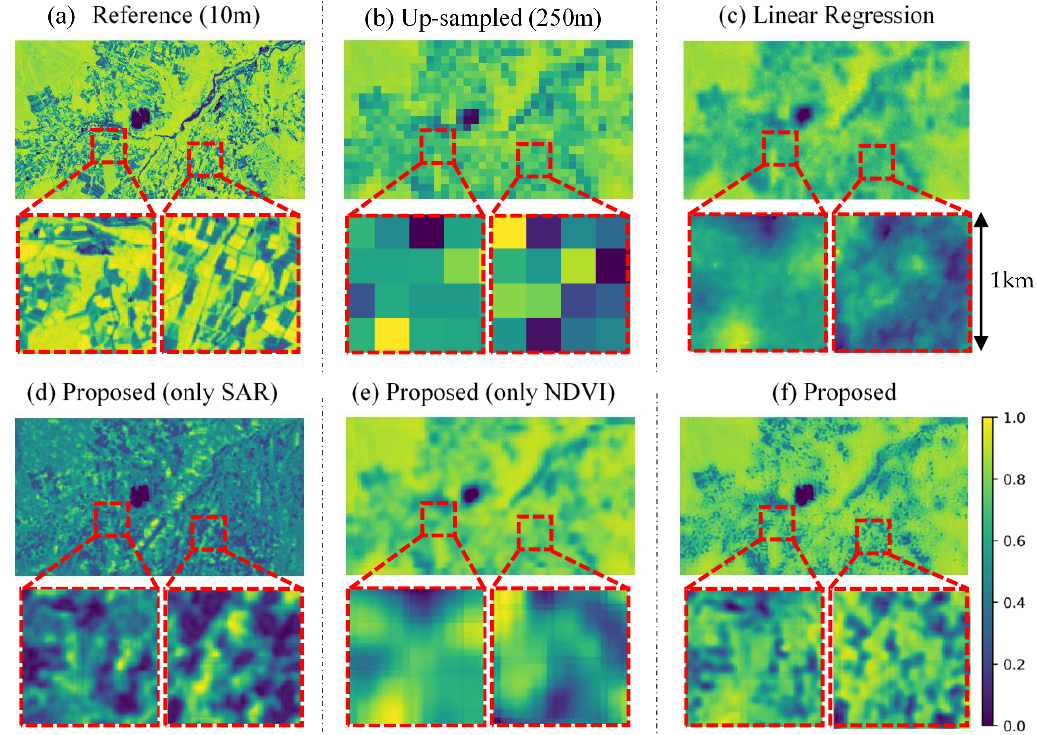
Figure 6. Qualitative result in Tsumagoi, 5 October 2020. ( a ) 10-m Sentinel-2 NDVI. ( b ) Up-sampled Sentinel-2 NDVI (250-m), ( c ) Predicted NDVI by linear regression. ( d ) Predicted NDVI by the proposed model with only synthetic aperture radar (SAR) input. ( e ) Predicted NDVI by the proposed method with only NDVI input. ( f ) Predicted NDVI by the proposed method. The bottom row displays enlarged views of the area in the red